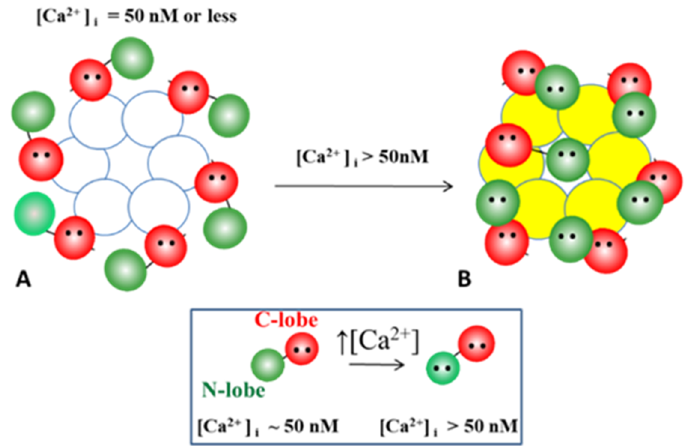
Figure 12. On the basis of the Ca-CaM-Cork model, at normal [Ca 2+ ] i (~50 nM) CaM is linked by the C-lobe to each connexin forming a hemichannel ( A ). With a [Ca 2+ ] i rise, the N-lobe plugs the pore. Although all of the six CaM N-lobes could theoretically simultaneously bind to their receptor and gate the channel, this seems unlikely because of steric hindrance. It is more likely that just one of the six N-lobes binds to its receptor site ( B ). If so, the first Ca 2+ -activated CaM-lobe wins the competition (first come, first served) and prevents other N-lobes from accessing the mouth of the channel.